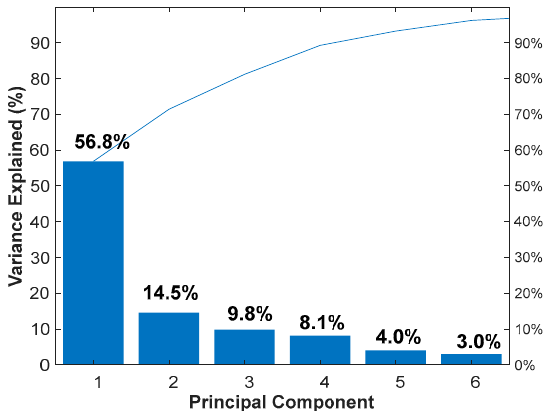
Figure 2. Contribution rates of the first six principal components.